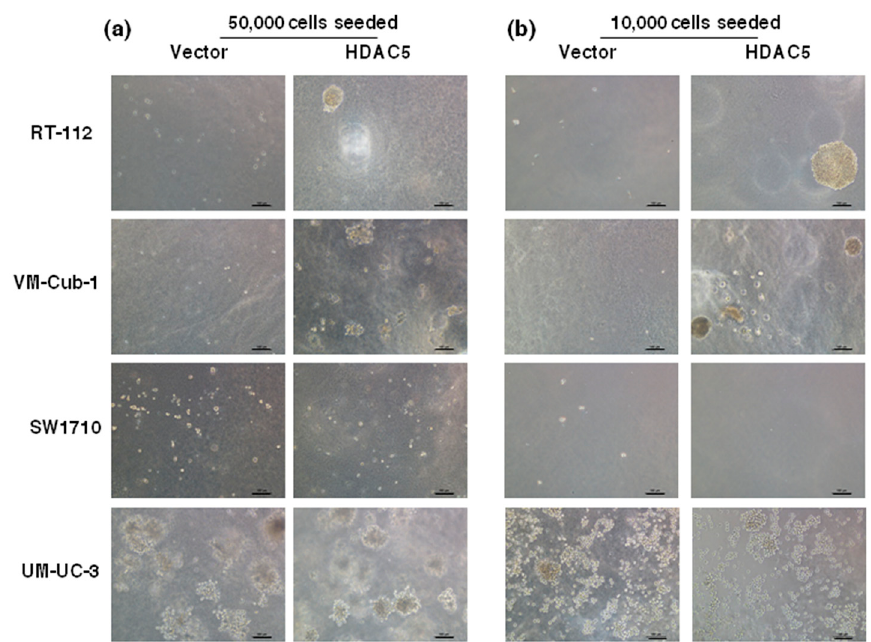
Figure 4. Colony formation of vector-only and HDAC5-transduced cells in soft agar. Soft agar colony formation assays were performed by seeding 50,000 cells ( a ) and 10,000 cells ( b ). Several images were captured and representative pictures for each cell variant are shown. The scale bars are 100 µ m.